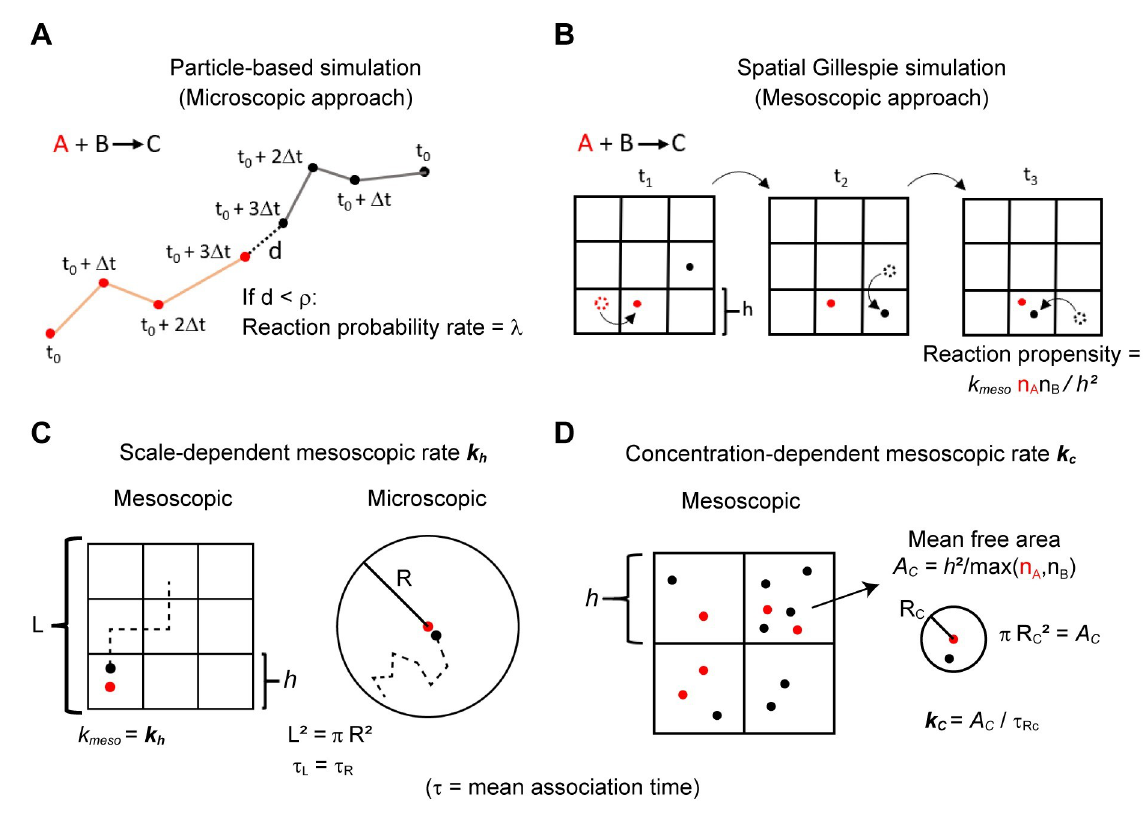
Fig 1. Simulation of a bimolecular reaction using a particle-based method and the spatial Gillespie approach. In our particle-based simulations ( A ) molecules undergo a random walk in continuous space and discrete time intervals Δ t . If a pair of reacting molecules are within a distance ρ , they can react with probability rate λ . In the spatial Gillespie approach ( B ), the domain is discretized using a grid, here with square elements of size h . Molecule jumps to adjacent grid elements and reactions take place within grid elements at random times. The propensity of a reaction within a grid element is proportional to the number of molecules (n A , n B ) and a mesoscopic rate constant k meso . ( C ) The scale-dependent mesoscopic rate k h ensures that the mean association time of two molecules in the reaction-diffusion master equation ( τ c ) matches an analogous microscopic representation ( τ R ). ( D ) A concentration-dependent mesoscopic rate constant is defined as k c = A area between molecules of the most abundant reactant in the grid element, estimated as A c = h 2 /max(n A , n B ), and τ Rc is the mean association time calculated from a microscopic model of two molecules that react in a circular domain with area π R c2 = A